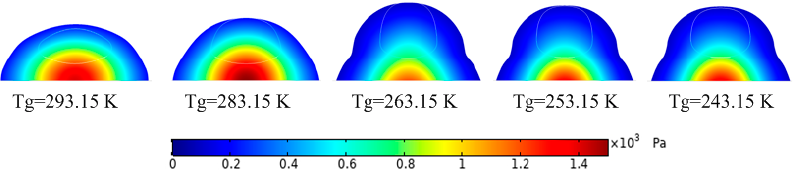
Figure 9. Pressure distribution cloud before water droplet impinging on bottom at t = 0.10 s. The white circle is the interface of water droplet and air.